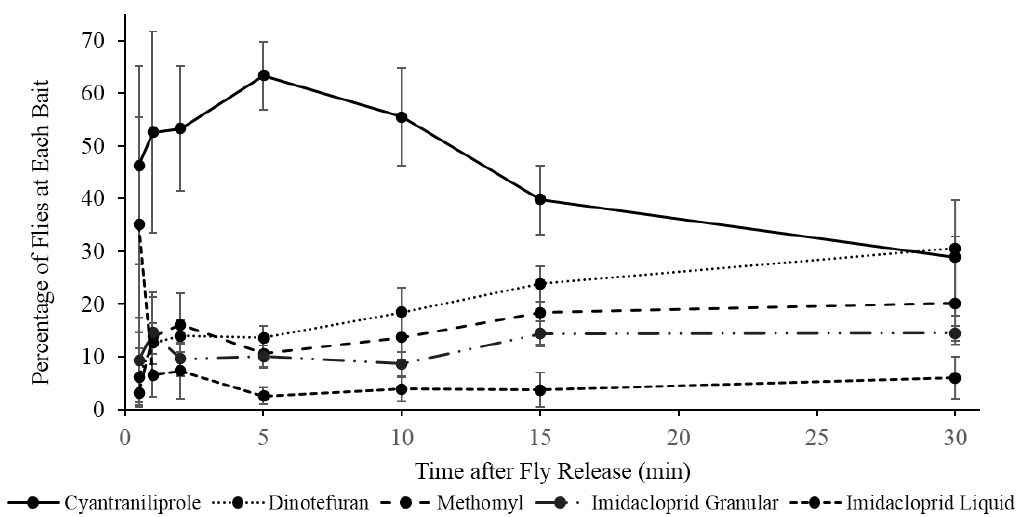
Figure 4. Percentage (±SEM) of responding flies on each fly bait at different time intervals over a 30-min period. Four replications of approximately 150 flies were performed ( n =